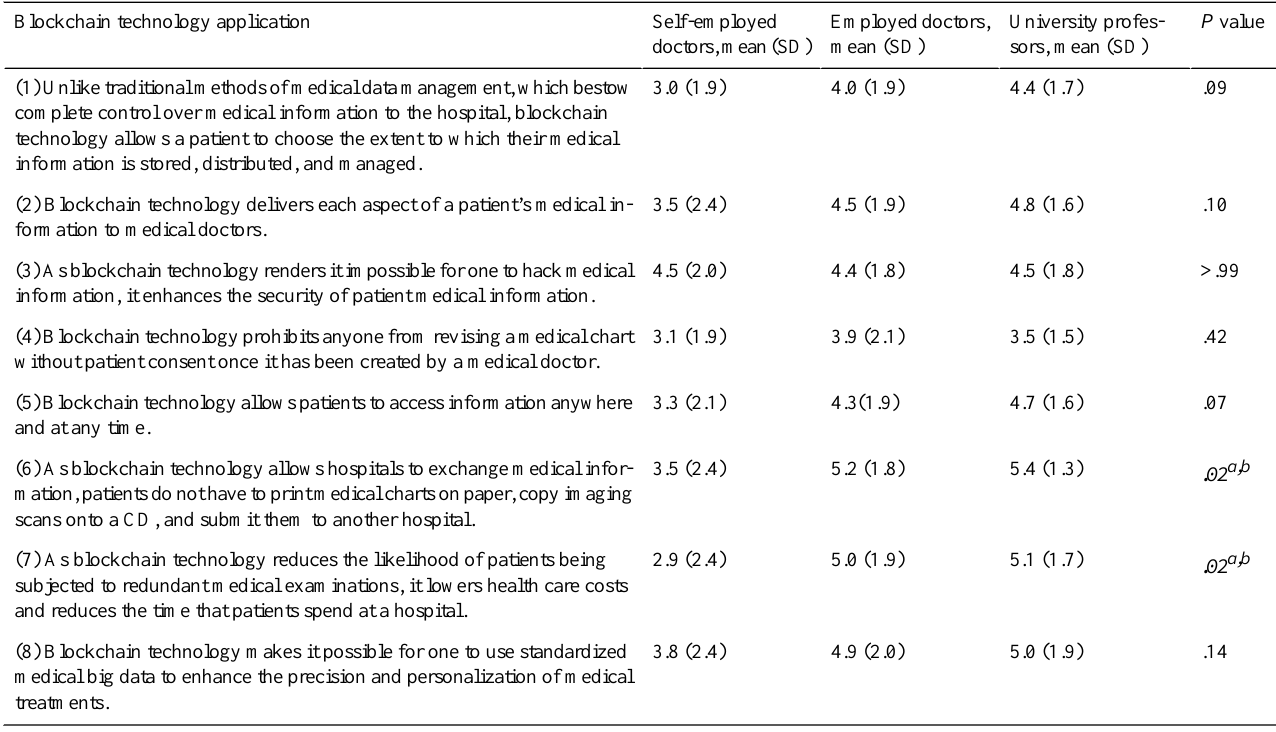
Table 5. Significance of the difference in attitudes toward new methods of managing medical information using blockchain technology among self-employed doctors, employed doctors, and university professors.